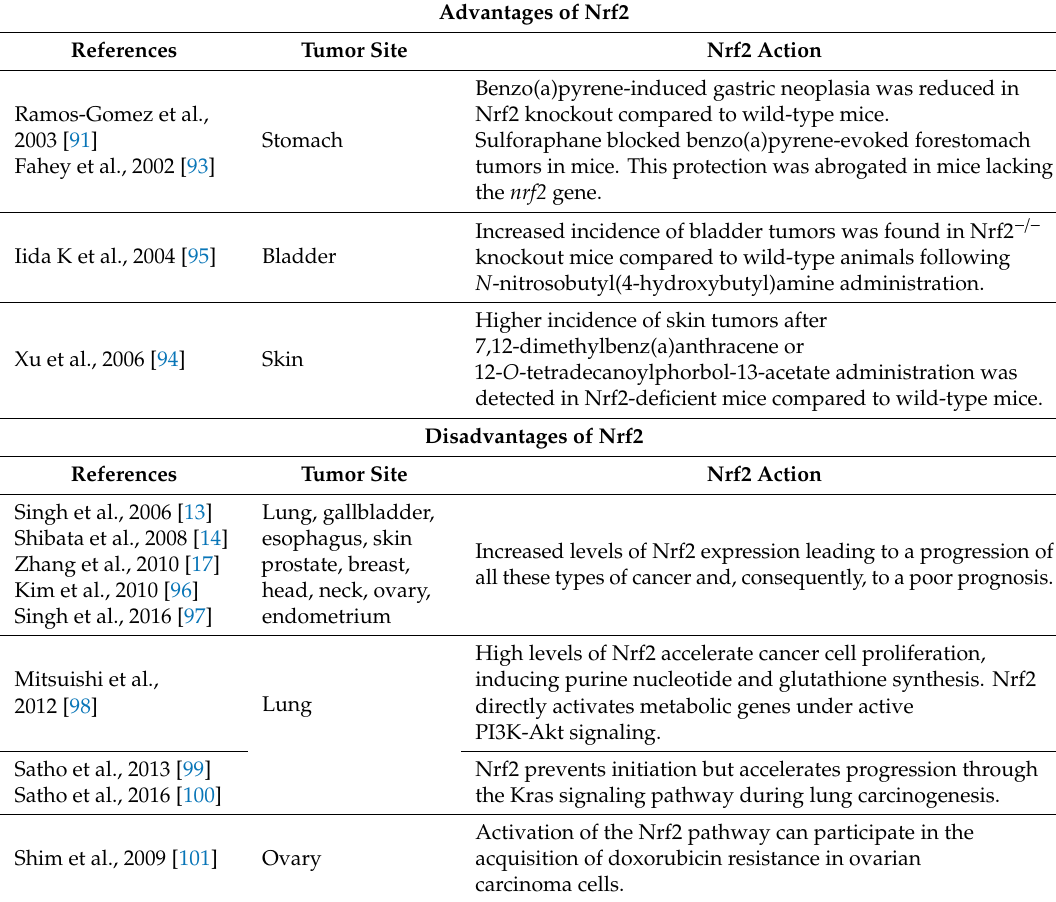
Table 3. Studies illustrating positive (advantages) and negative (disadvantages) roles of Nrf2 in cancers of various